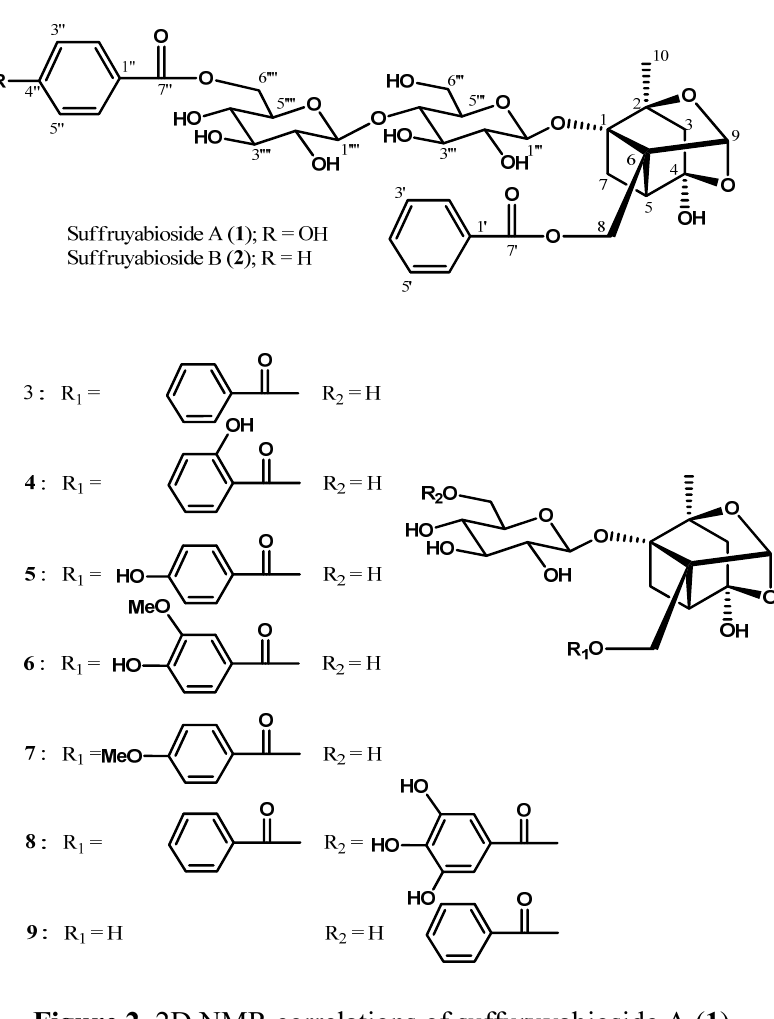
Figure 1. Structures of suffuruyabiosides A ( 1 ) and B ( 2 ), and seven known compounds 3 – 9 .